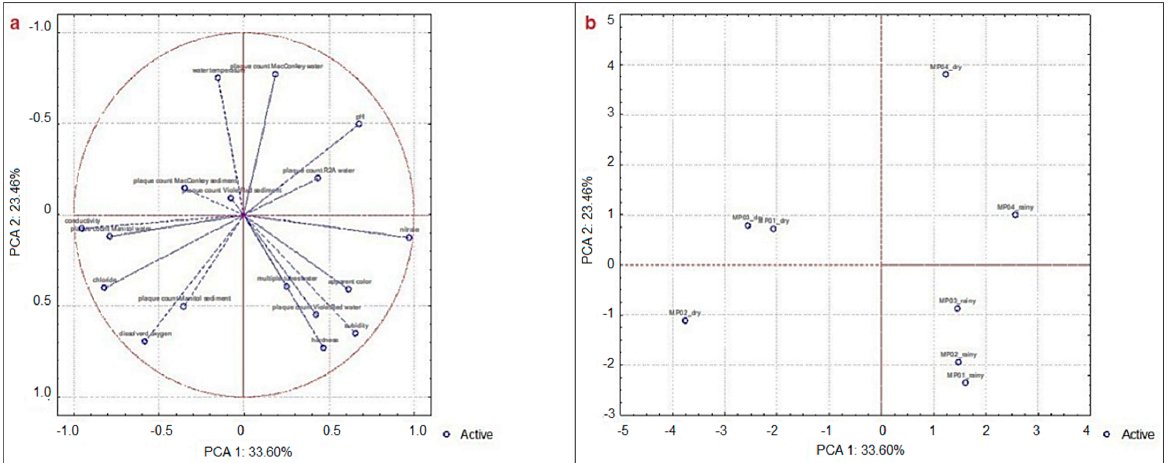
Figure 2. PCA of physicochemical and microbiological parameters regarding the quality of water and sediments of Meia Ponte River. ( a ) Dot and vector graph of physicochemical and microbiological parameters. ( b ) Loads graph of the influence of physicochemical and microbiological parame- ters in the sampling points and their distribution based on this influence. The two-by-two correlations were considered very strong among: chlorides with con- ductivity and dissolved oxygen—positive correlation; among conductivity and nitrate— negative correlation; apparent color with hardness and turbidity—positive correlation; hardness and turbidity, dissolved oxygen with bacterial count in the salty mannitol me- dium in sediment samples—positive correlation; pH with bacterial counts with water samples in MacConkey medium—positive correlation and Mannitol salty medium—neg- ative correlation; turbidity and count in Violet Red medium—positive correlation; and